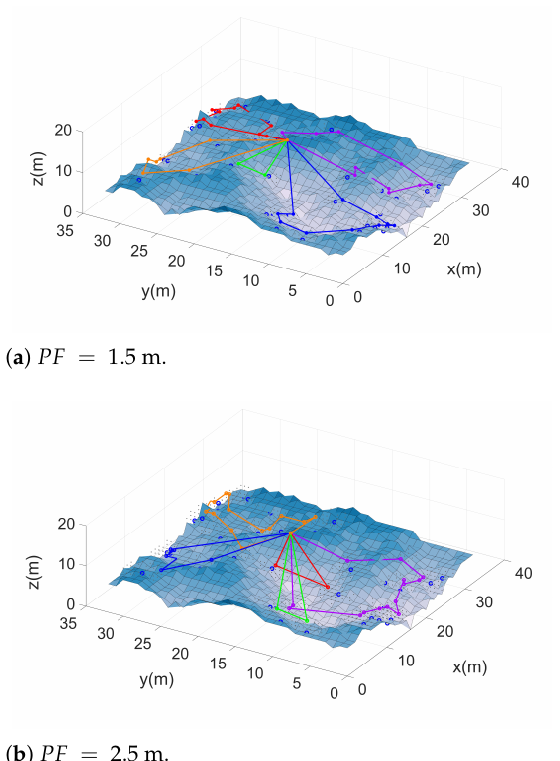
Figure 17. Trajectories of O-AUV+ANSGA with different PF